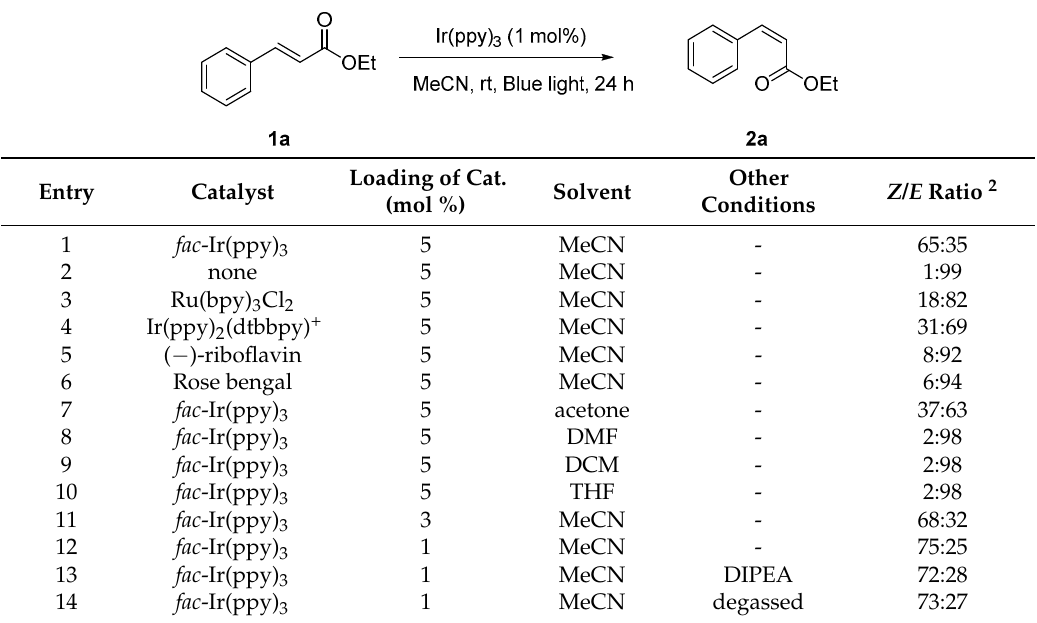
1 Reaction conditions: Reactions were performed with 0.2 mmol of substrates in indicated